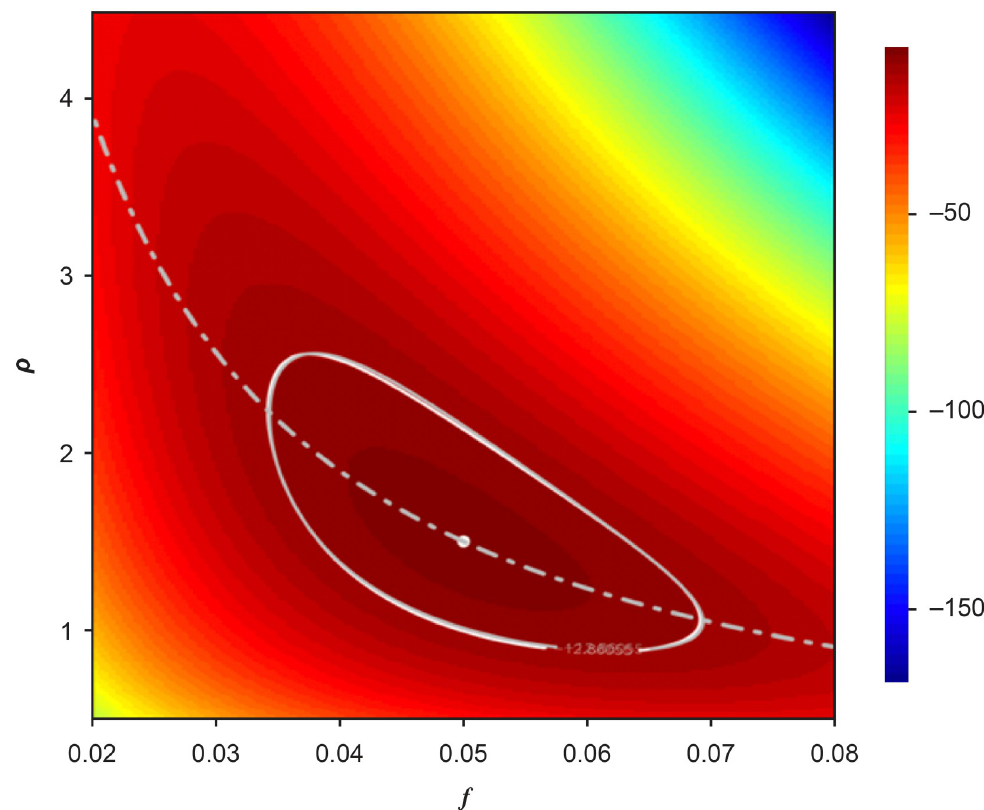
Fig 9. The profile log-likelihood (Eq 40) for the fraction of individuals who are infected and symptomatic f and the ratio of of the fraction of individuals who are infected and asymptomatic to those who are infected and symptomatic ρ when the test data are the means of T S , P S , and P . The white dot denotes the true values of the parameters. The 95% CR contour is shown in white for the exact binomial likelihoods and in gray for the Gaussian approximation to those likelihoods. The white dotted line is obtained by replacing ^ g in Eq 28 by its MLE value, replacing ^ f by an arbitrary value f , and then viewing the right side as an equation for the ratio ρ ( f ) of asymptomatic to symptomatic infected individuals.